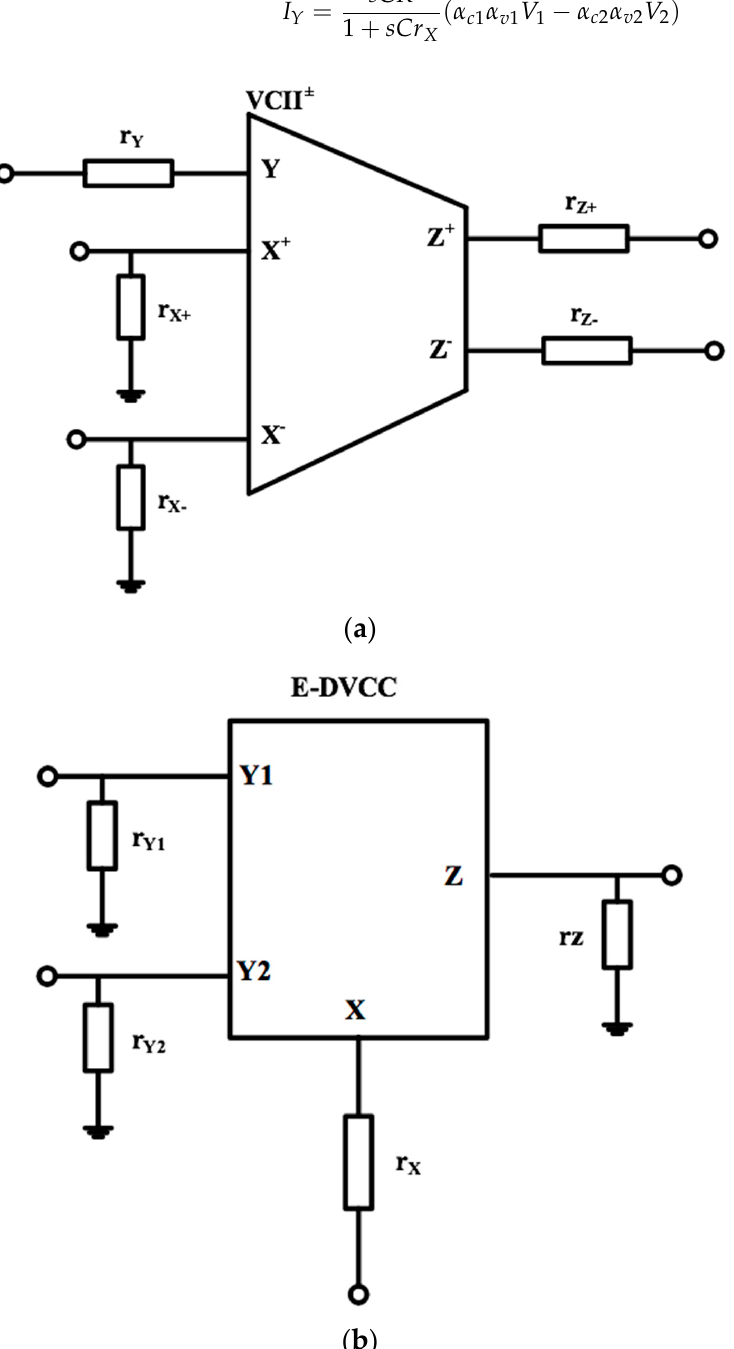
Figure 3. Non-ideal impedances of ( a ) VCII ± and ( b ) E-DVCC.